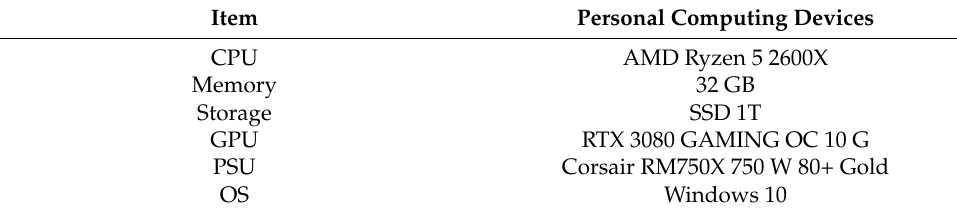
Table 1. Environment setup.